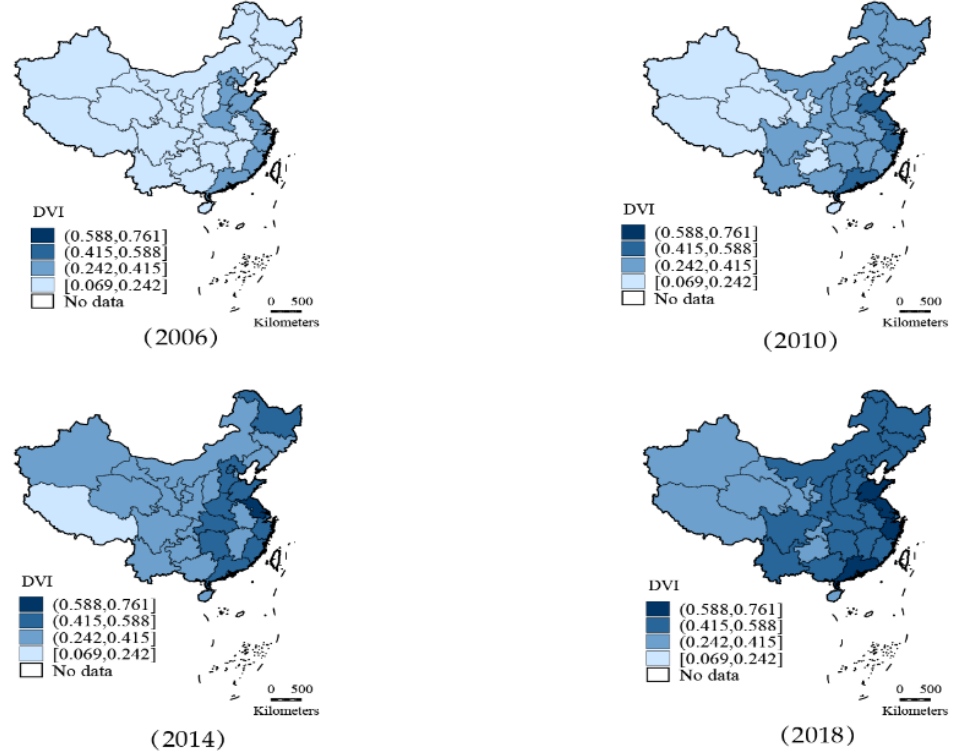
10 of 21 Figure 2. Average DVI and growth rates of 31 provinces from 2005 to 2018 . Figure 3 is the spatial and temporal trend of DVI development in 31 provinces of mainland China in the past 2005–2018 years, which was drawn up by ArcGIS software. Due to the space limitation, it only lists the trend of DVI in the years 2006, 2010, 2014, and 2018. It can be seen from Figure 3 that the DVI in China has three characteristics in terms of space-time evolution: the level of China’s digital village development shows a relatively evident growth trend, the number of provinces with digital village develop- ment levels below 0.415 decreased from 22 to 8 provinces from 2006 to 2018, and the number of provinces above 0.588 increased by five provinces. The level of DVI in China is decreasing from the eastern to the western region. The provinces and cities with a higher level of DVI are mainly in the eastern region, such as Shandong, Jiangsu, Zhejiang, and Guangdong provinces; the provinces with low levels are primarily dis-